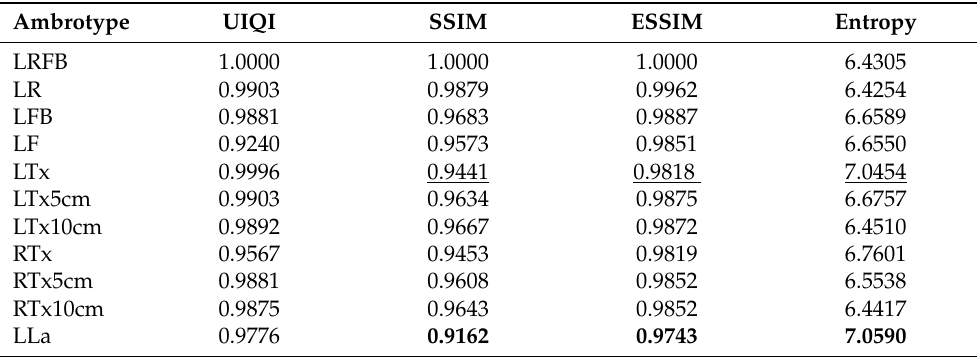
Table 1. Ambrotype. Comparison of images scanned in different scan modes with a reference image scanned in LRFB mode.